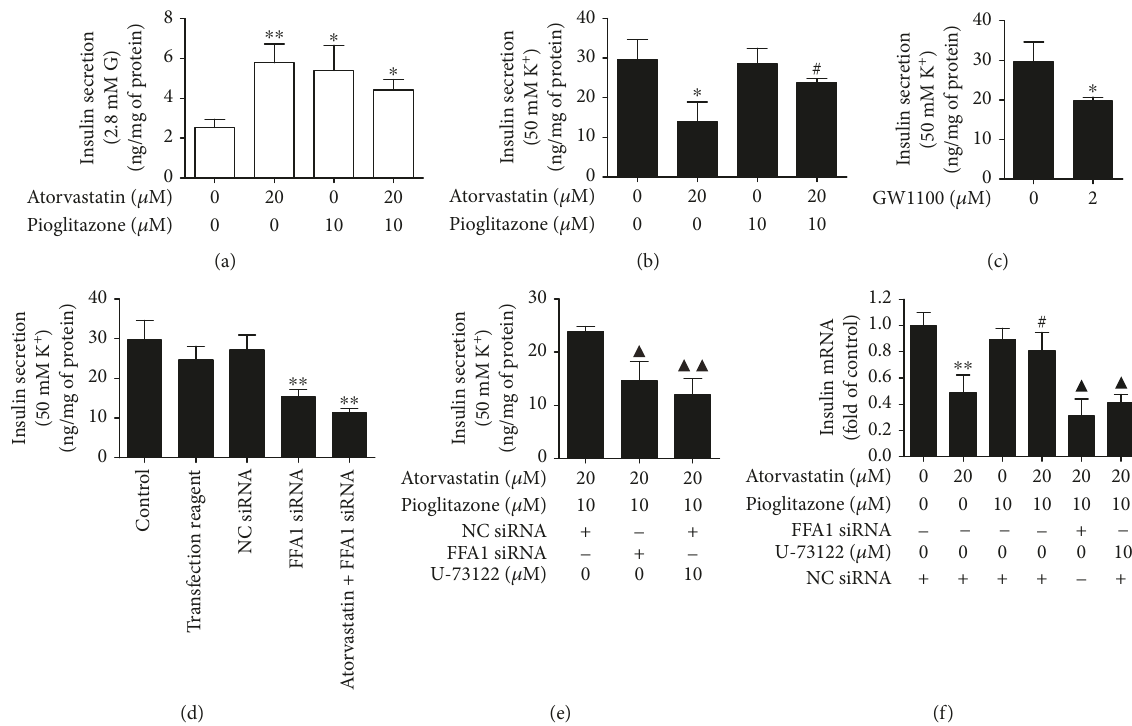
Figure 3: E ff ect of atorvastatin, pioglitazone, and FFA1-PLC signaling pathway inhibitors on basal insulin secretion and potassium-stimulated insulin secretion in INS-1 cells. (a) Administration of 10 μ M pioglitazone for 24h preserved the increased basal insulin secretion by 20 μ M atorvastatin. (b) Administration of 10 μ M pioglitazone for 24 h prevented the reduction in potassium-stimulated insulin secretion induced by 20 μ M atorvastatin. (c) FFA1 antagonist 2 μ M GW1100 signi fi cantly reduced the potassium-stimulated insulin secretion after 24h of incubation. (d) Knockdown of FFA1 using siRNA signi fi cantly reduced the potassium-stimulated insulin secretion. Atorvastatin and FFA1 siRNA together also decreased the potassium-stimulated insulin secretion. (e) The preventive e ff ect of pioglitazone on